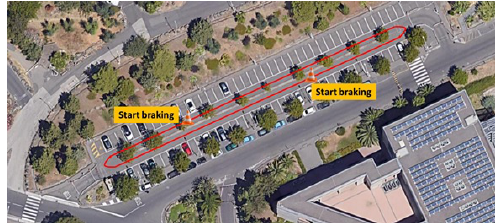
Figure 3. Satellite view of the calibration route.